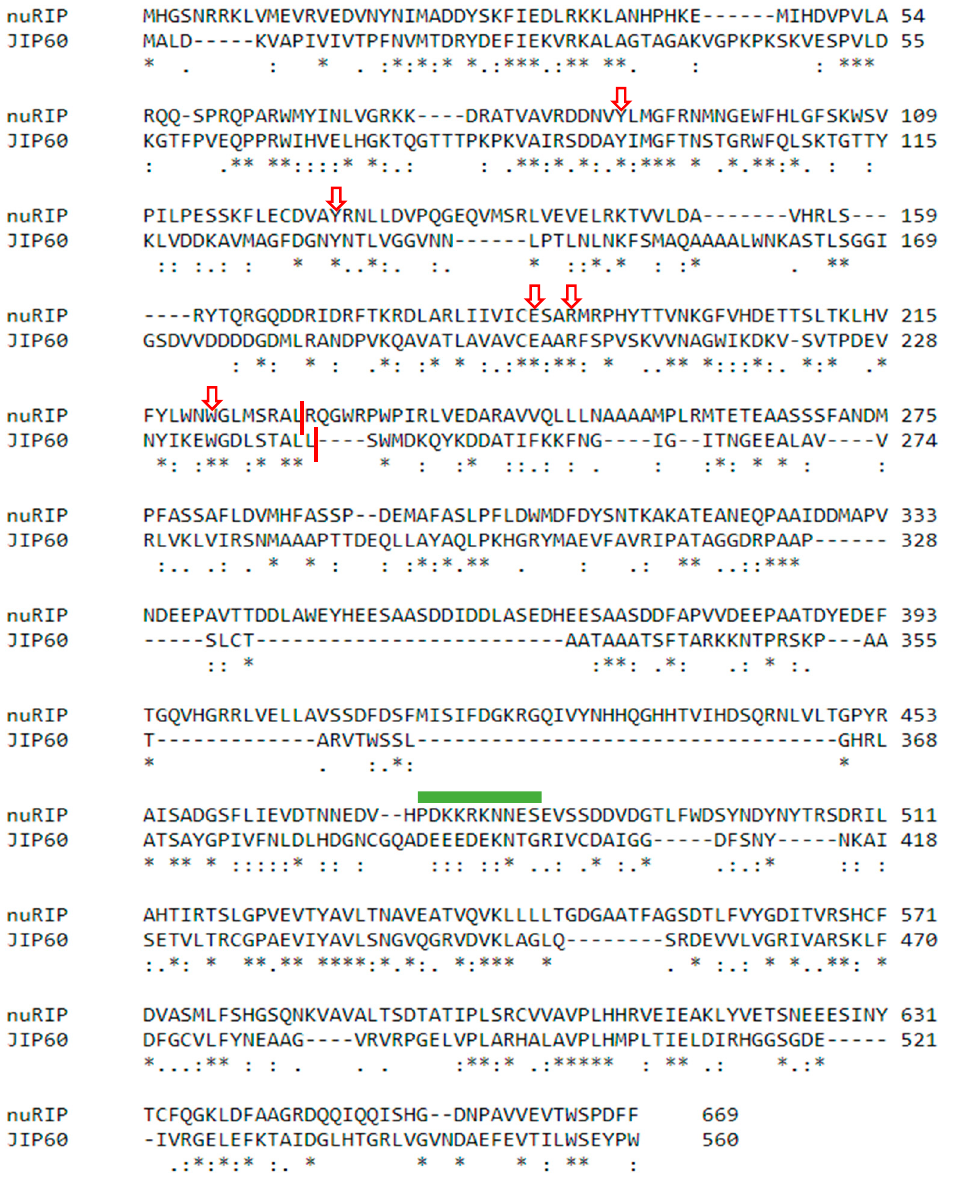
Figure 2. Alignment between the amino acid sequences for JIP60 and nuRIP. Red arrows point towards the active site residues for the RIP domain. The green bar shows the location of the nuclear localization signal in nuRIP. The vertical red lines indicate the end of the RIP domain for the two RIPs. Asterisks refer to residues that are fully conserved, colons indicate residues with highly similar properties, dots indicate residues with weakly similar properties.